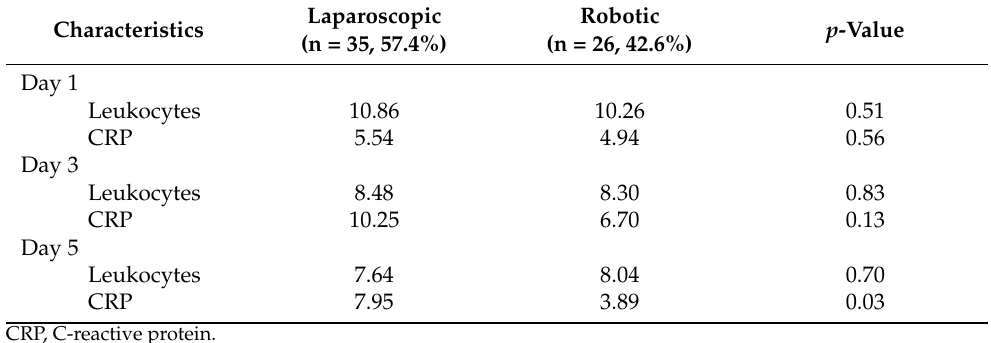
Table 3. Differences of leukocytes/C-reactive protein (CRP) over time. Table 4. Differences of leukocytes/C-reactive protein (CRP) over time.